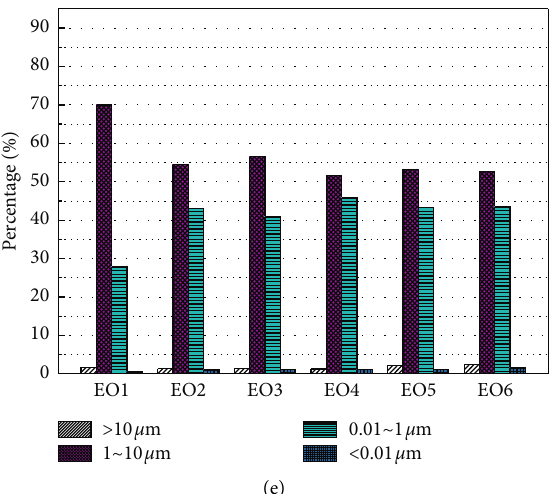
Figure 9: Volume percentage of different pore diameters. (a) Anode. (b) Near anode. (c) Middle. (d) Near cathode. (e)